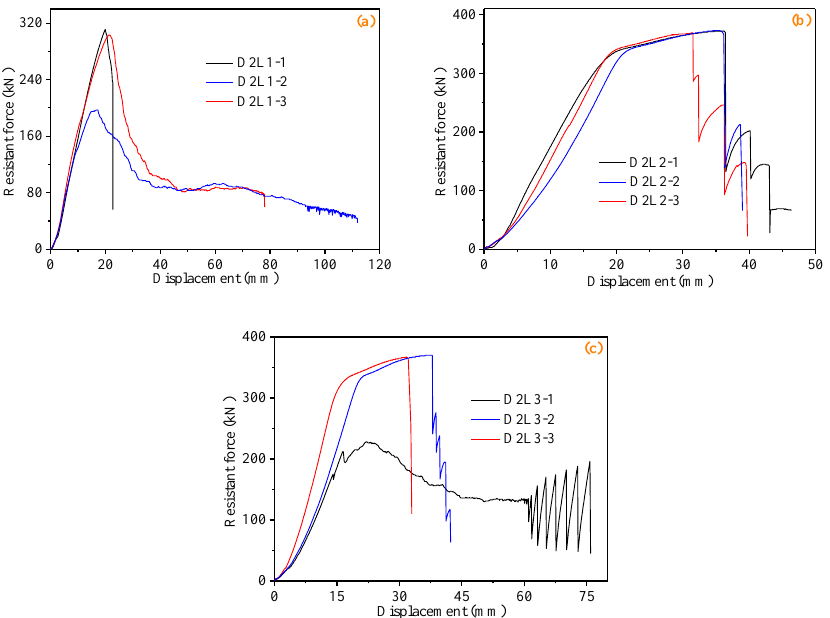
Figure 8. Mechanical response of flexible bolts with different Ø33 mm locking casing lengths: ( a ) 100 mm, ( b ) 120 mm, and ( c ) 140 mm.